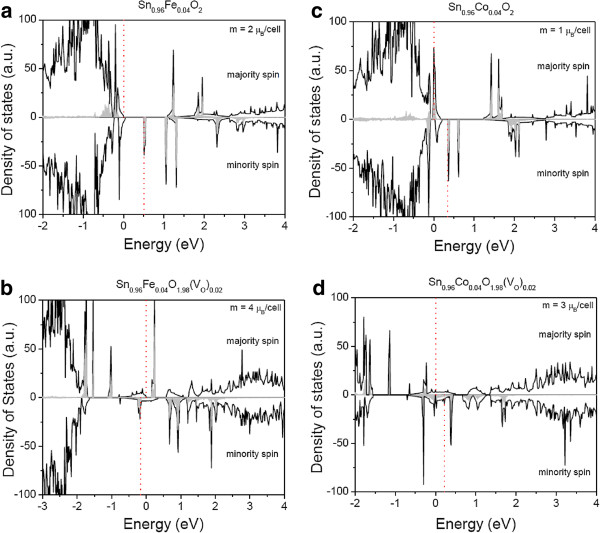
 The ground state total (black lines) and projected (gray shaded areas) density of states. The transition metal 3d-derived states for the majority and minority spins for the ground state magnetic moment are shown for (a) Sn0.96Fe0.04O2, (b) Sn0.96Fe0.04O1.98(VO)0.02, (c) Sn0.96Co0.04O2, and (d) Sn0.96Co0.04O1.98(VO)0.02. The vertical dashed lines correspond to the highest occupied energy level for the majority and minority spins.